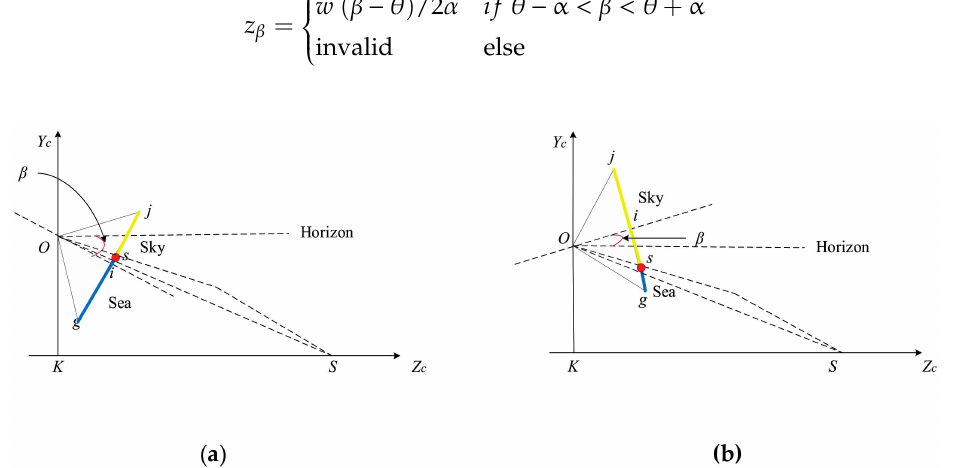
Figure 4. Geometric relationship between the SSL position and camera pitching motion. ( a ) Clockwise rotation. ( b ) Counterclockwise rotation.